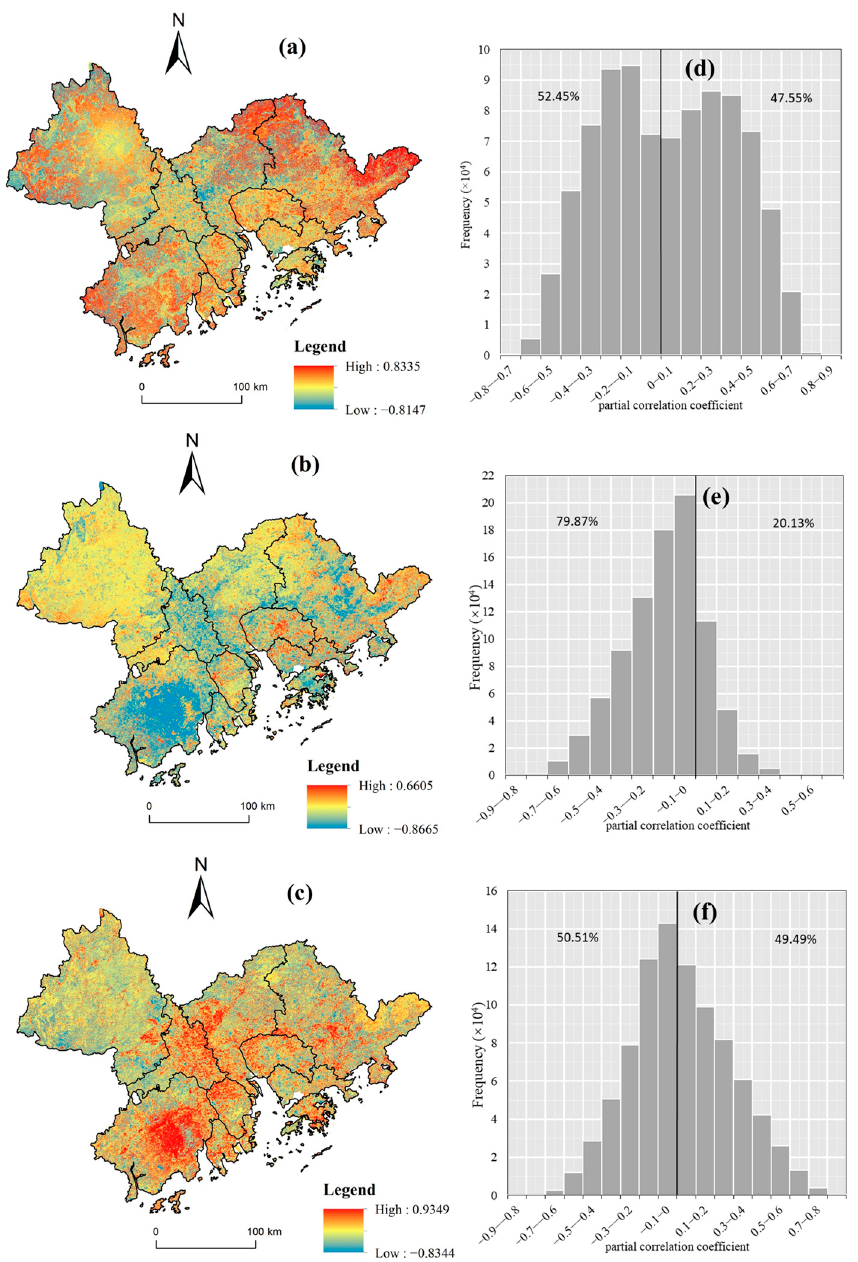
Figure 6. Partial correlations between NPP a and ( a , d ) temperature, ( b , e ) precipitation, and ( c , f ) solar radiation in the GBA from 2000 to 2020, with corresponding frequency distributions.